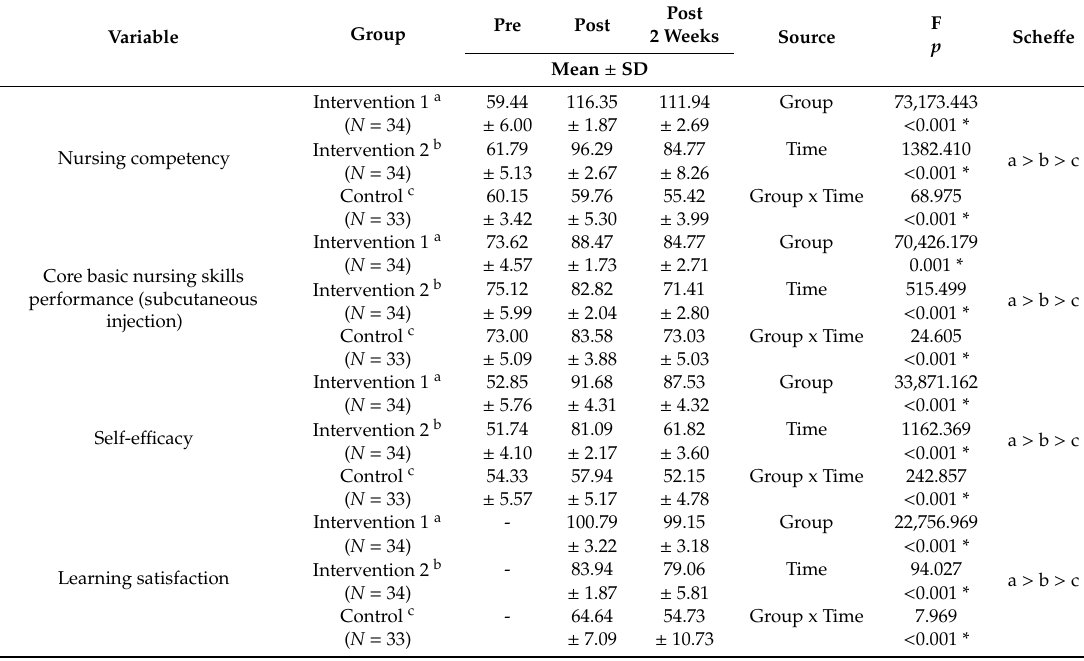
Table 4. E ff ects of simulation practicum using flipped